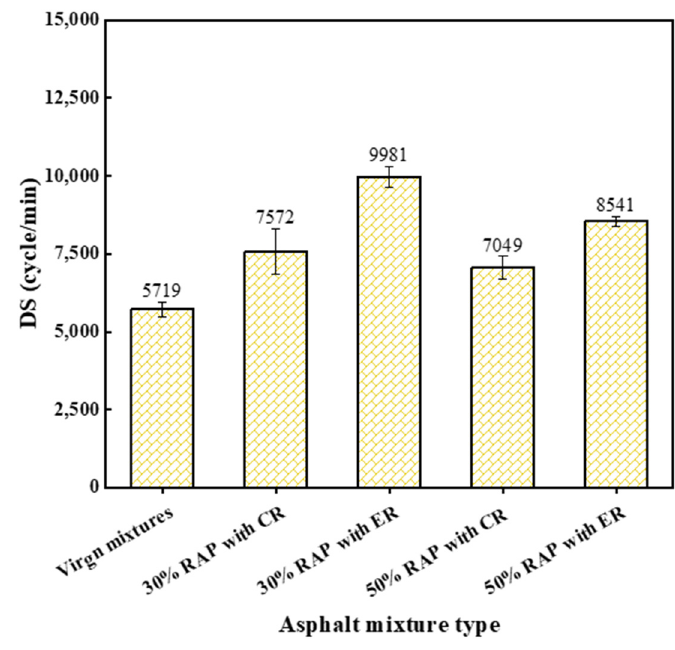
Figure 8. The dynamic stability (DS) results of each studied mixture.